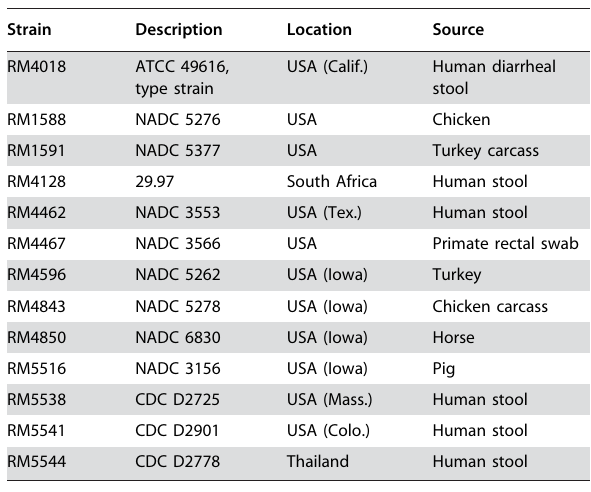
Table 4. Strains used in the comparative genomic